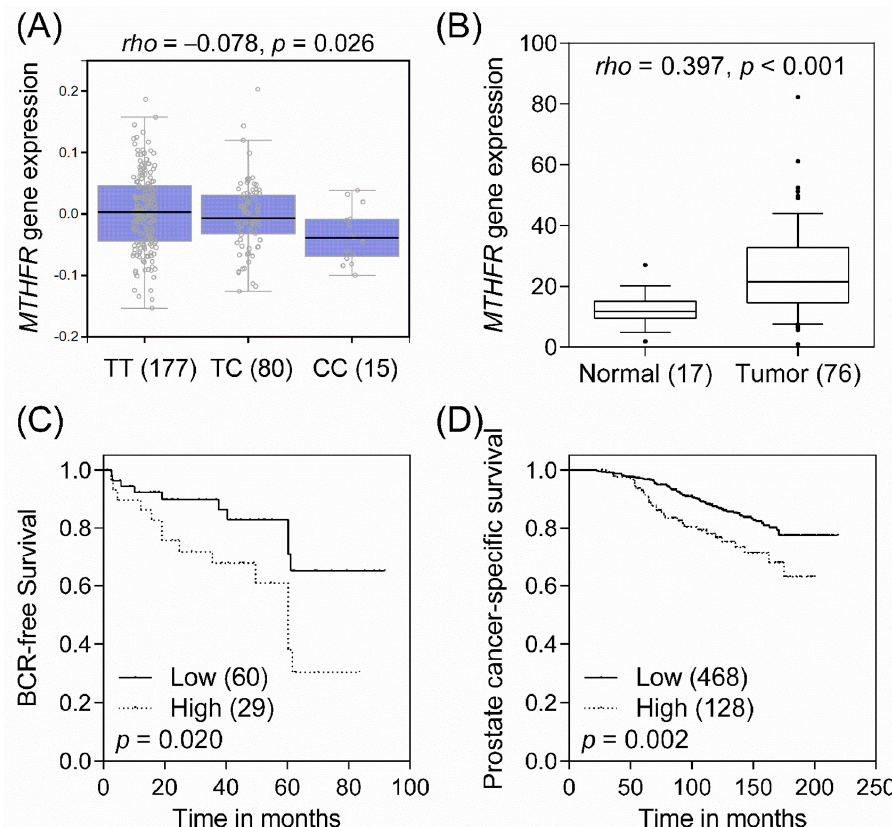
Figure 2. Functional analyses of MTHFR rs9651118 with prostate cancer progression: ( A ) Correlation of rs9651118 genotypes with MTHFR mRNA expression. Boxplot represents MTHFR mRNA